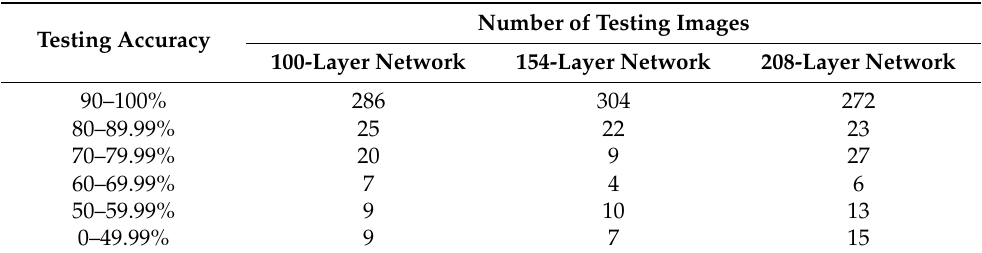
Table 4. Segmentation accuracy of the three networks on the testing dataset, divided into six different accuracy